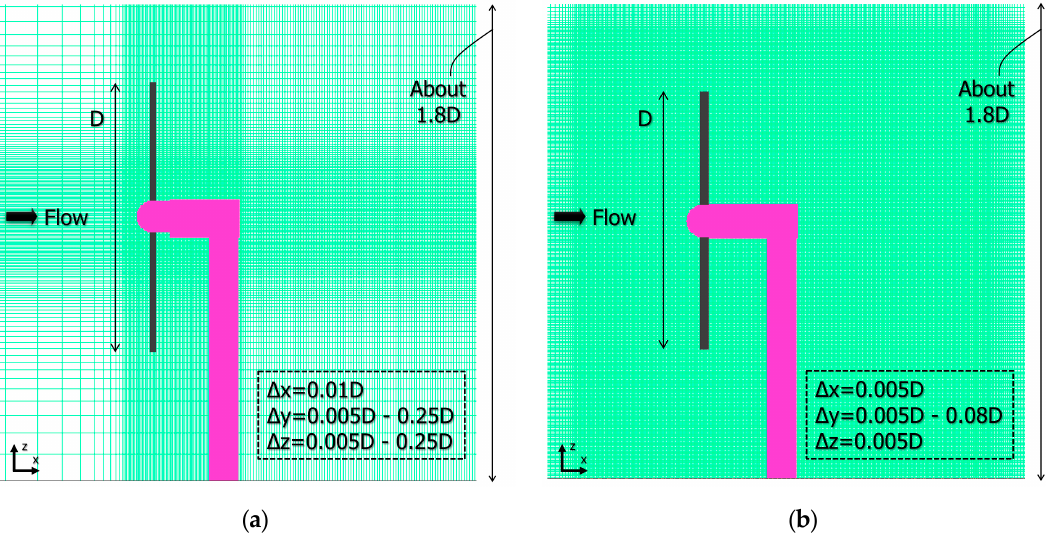
Figure A6. Comparison of computational grid: ( a ) standard grid (same grid as Figure 12), and ( b ) fine grid.